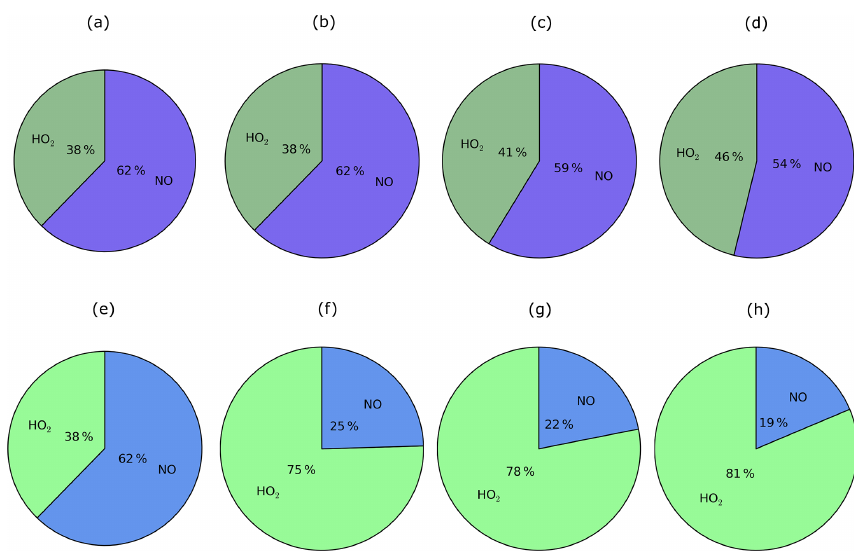
Figure 10. For the peroxy radical, chemical removal (top row; a–d ) and SOA production (bottom row; e–h ) for the Multi_nap (first column; a, e ), Multi_nap_yield (second column; b, f ), Multi_tol_yield (third column; c, g ), and Multi_benz_yield (fourth column; d, h ) simulations, which are described in Table